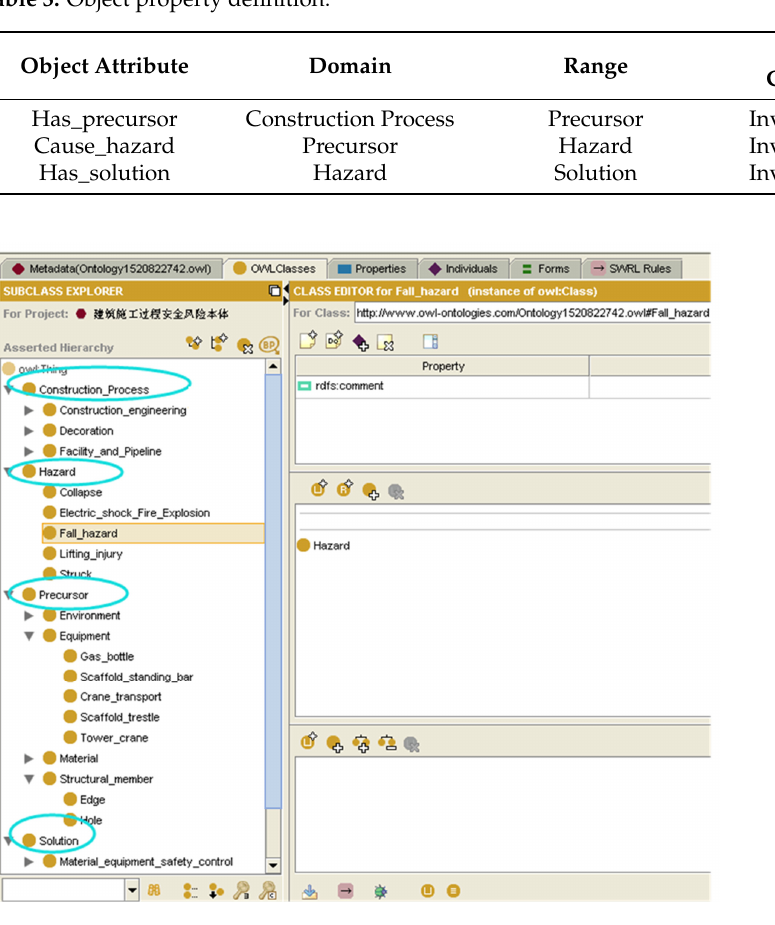
Figure 2. Object relationship setting.